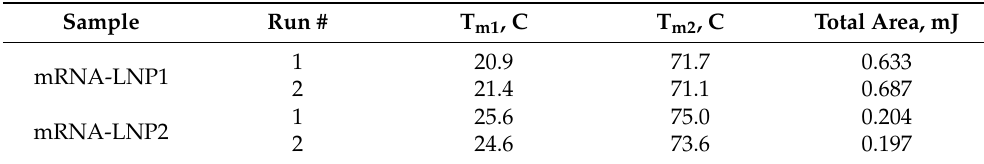
Table 9. Summary of the results of DSC measurements of mRNA-LNP samples. Repeat measurements were made with an interval of 9